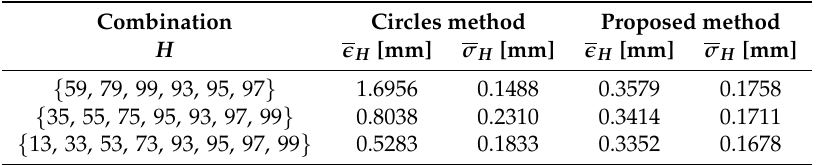
Table 1. Comparison between the proposed method and the circles